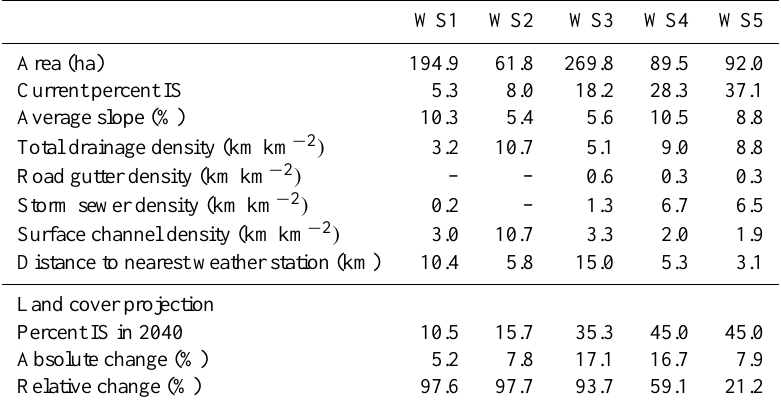
Fig. 1. Five headwater stream watersheds located in four cities (one each in Altoona, Ankeny, and Johnston, and two in Pleasant Hill) in Polk County, central Iowa. Shaded areas represent impervious surface in 2011, watershed boundaries for WS1 through WS5 are outlined with red lines. Table 1. Geographic characteristics, drainage density, distance to nearest weather station, and projected percent impervious surface (IS, 2040) for five urban watersheds (WS1 to WS5) in central Iowa representing a percent impervious surface gradient. Total drainage density is the sum of road gutter, storm sewer and surface channel